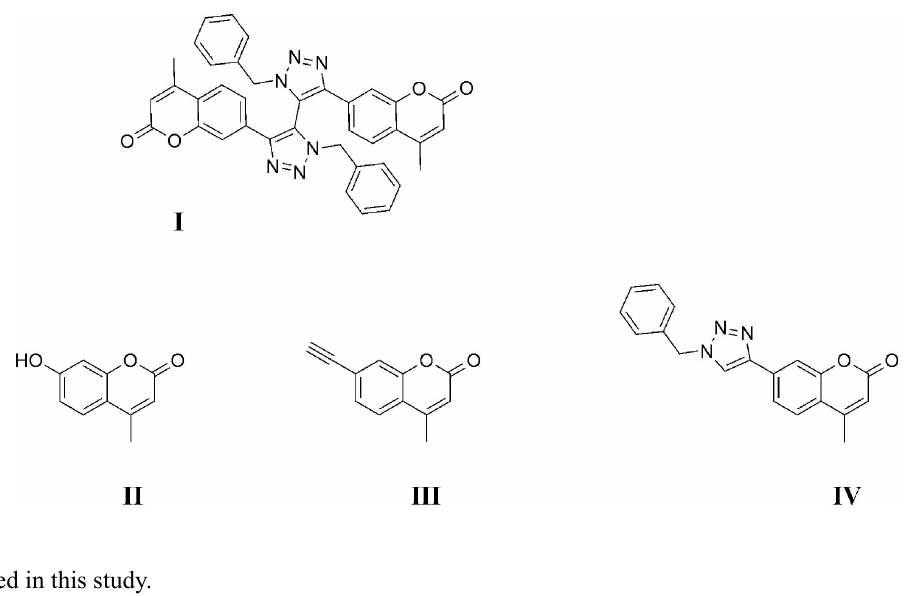
Perspective view of (I) showing the atom labelling scheme. Non-hydrogen atoms are represented by Gaussian ellipsoids at the 20% probability level. Hydrogen atoms are not